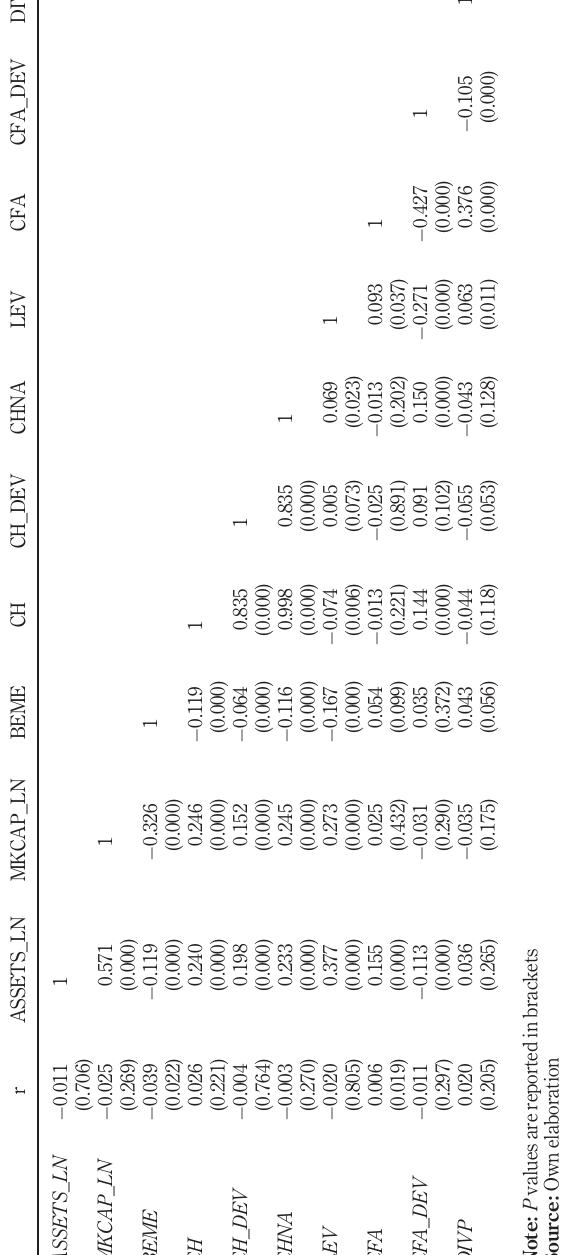
Table 3. Correlation